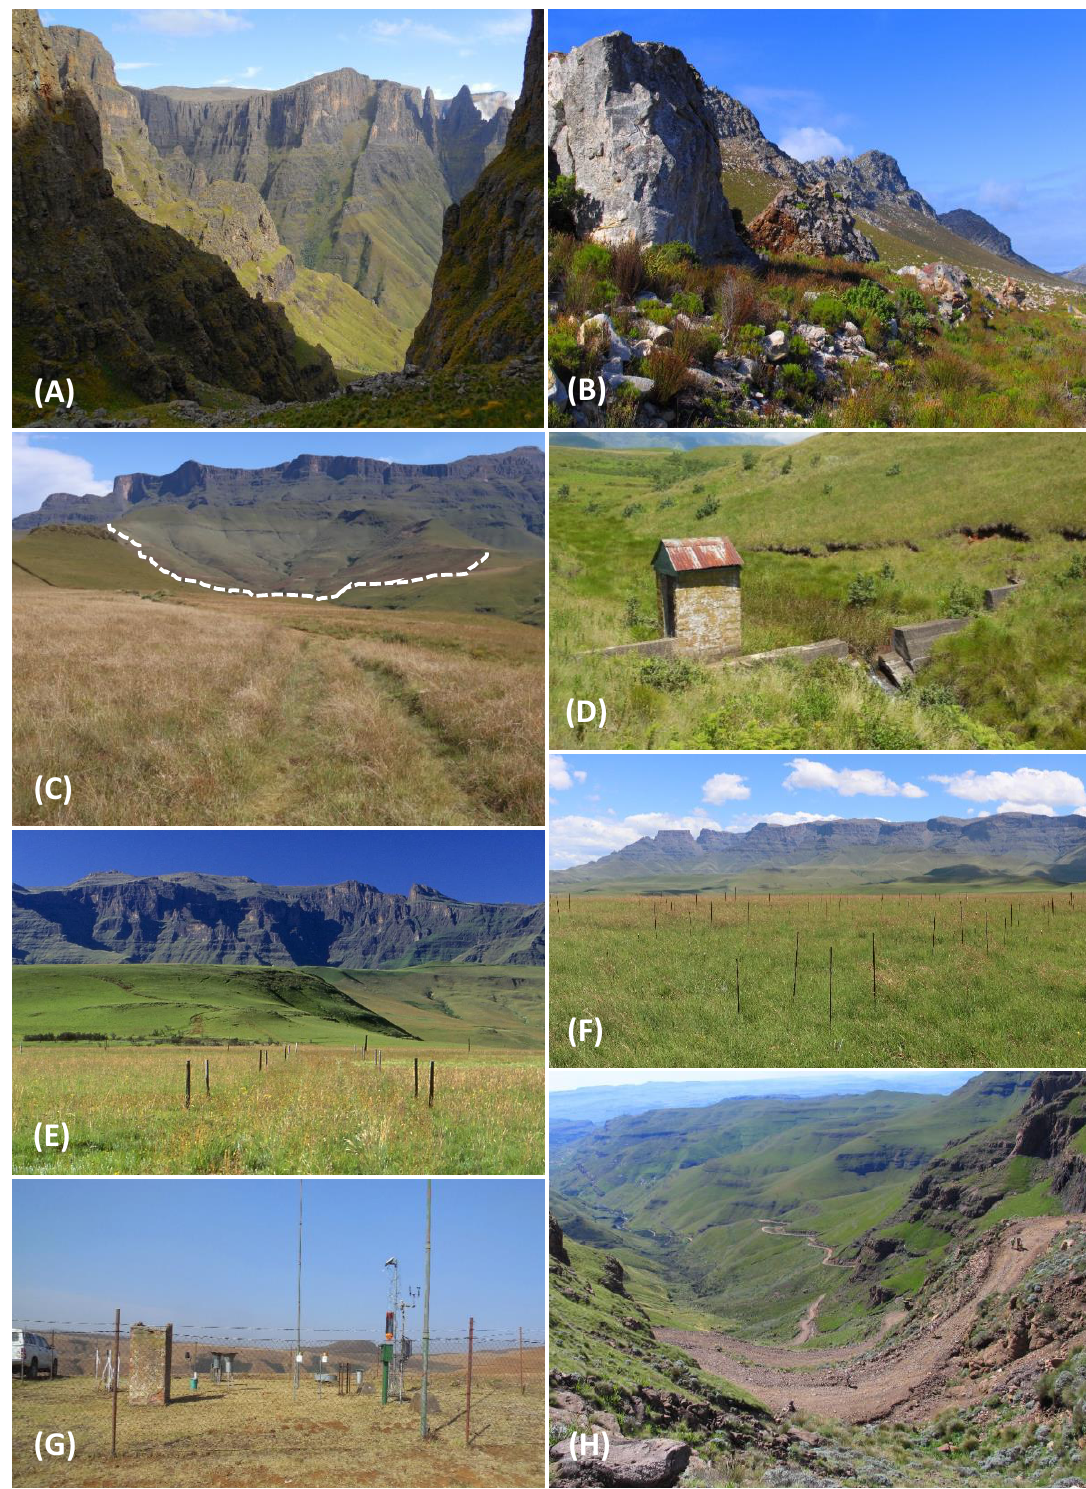
Figure 2. Photographic representation of LTER in Southern Africa’s mountain regions: ( A ) Maloti-Drakensberg, Great Escarpment; ( B ) Cape Fold Belt; ( C ) Research Catchment II at Cathedral Peak (above dashed line) after the removal of alien trees; ( D ) V-notched gauging weir used to measure stream flow; ( E ) Brotherton Fire Experiment; ( F ) Nutrient Network site; ( G ) Campbell Scientific automatic weather station; ( H ) MIREN site at Sani Pass straddling South Africa and Lesotho. All photos by C. Carbutt.